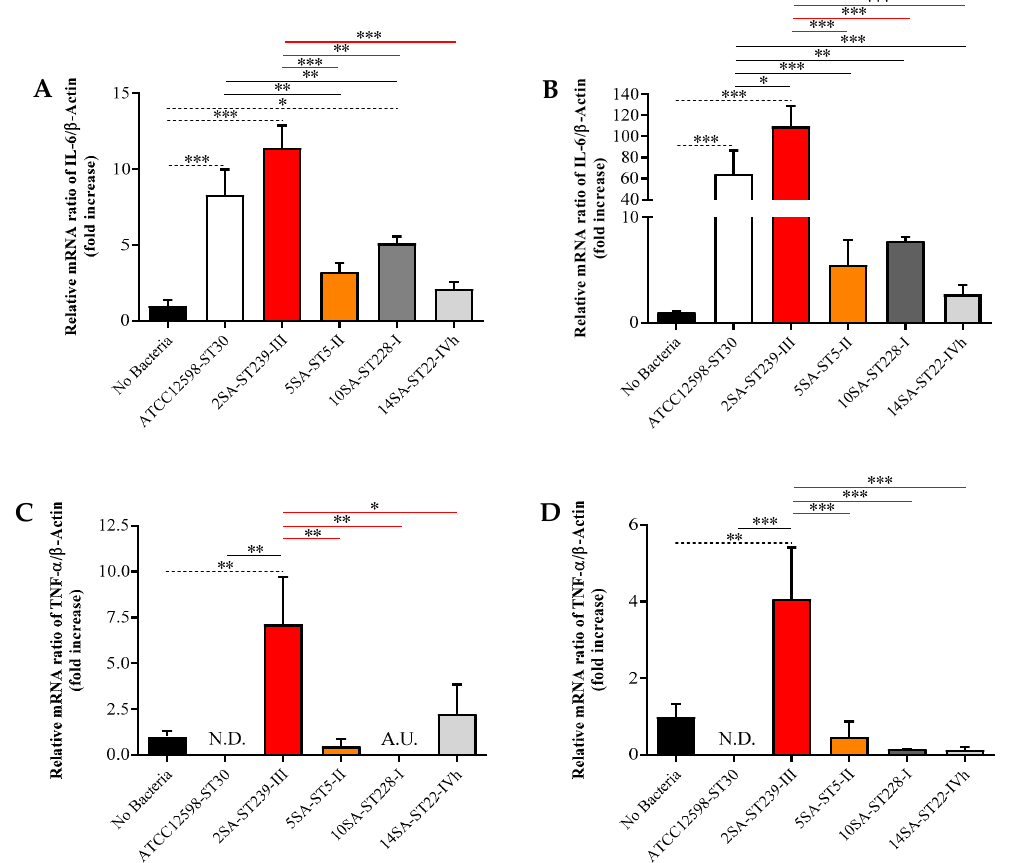
Figure 3. Gene expression of interleukin 6 (IL-6) ( A , B ) and tumor necrosis factor alpha (TNF- α ) ( C , D ) in uninfected (No Bacteria) MG-63 osteoblast-like cells and in MG-63 cells infected at an MOI of 100:1 with five different S. aureus strains detected at 3 and 24 h p.i. N.D. = not detectable; A.U. = almost undetectable. The abundance of each mRNA is expressed relative to the abundance of β -actin-mRNA. Values are means ± SD of three independent experiments. Significant compariScheme 0. * significantly different, p < 0.05;** significantly different, p < 0.01; *** significantly different, p <